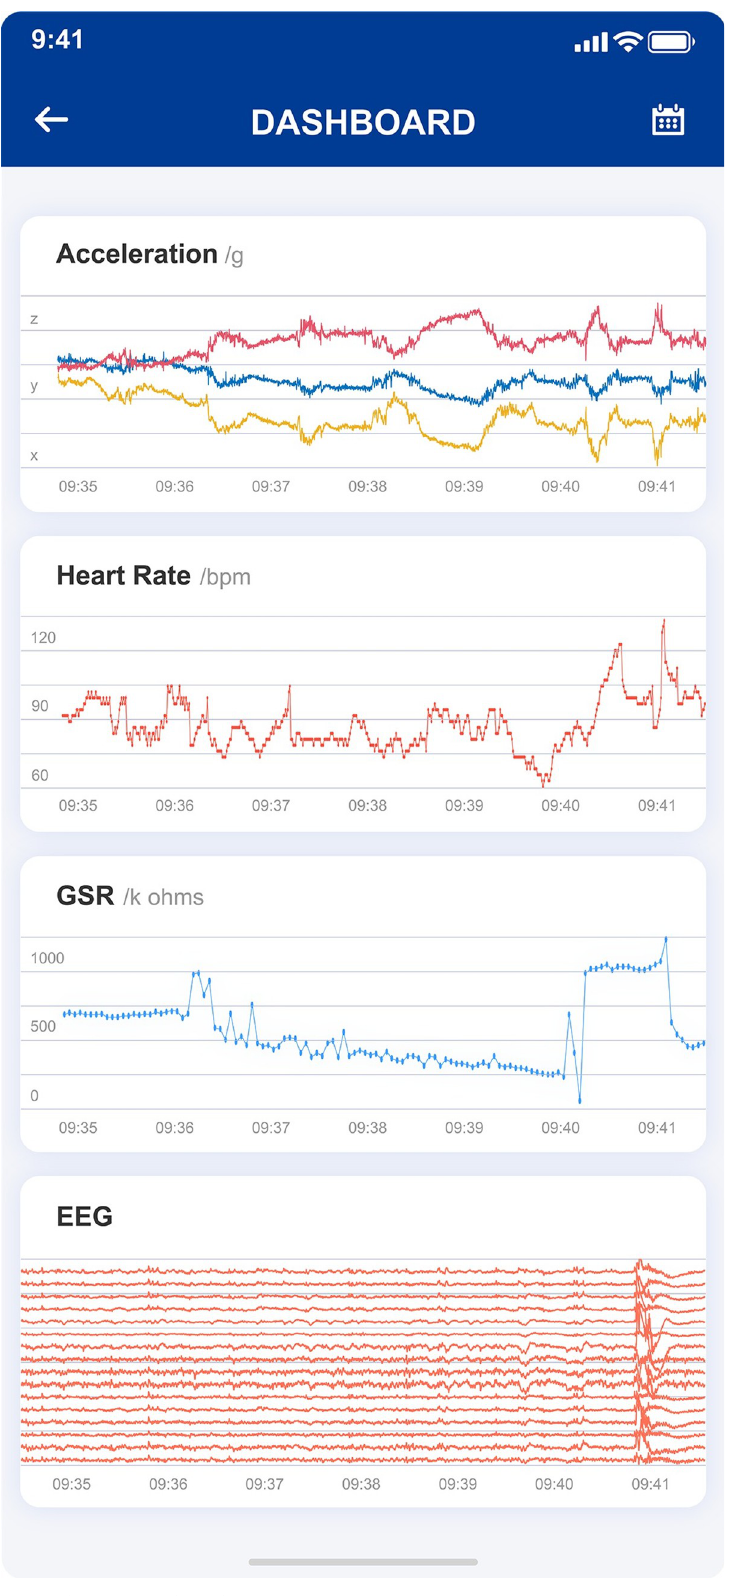
Fig 7. The App interface of LOOP